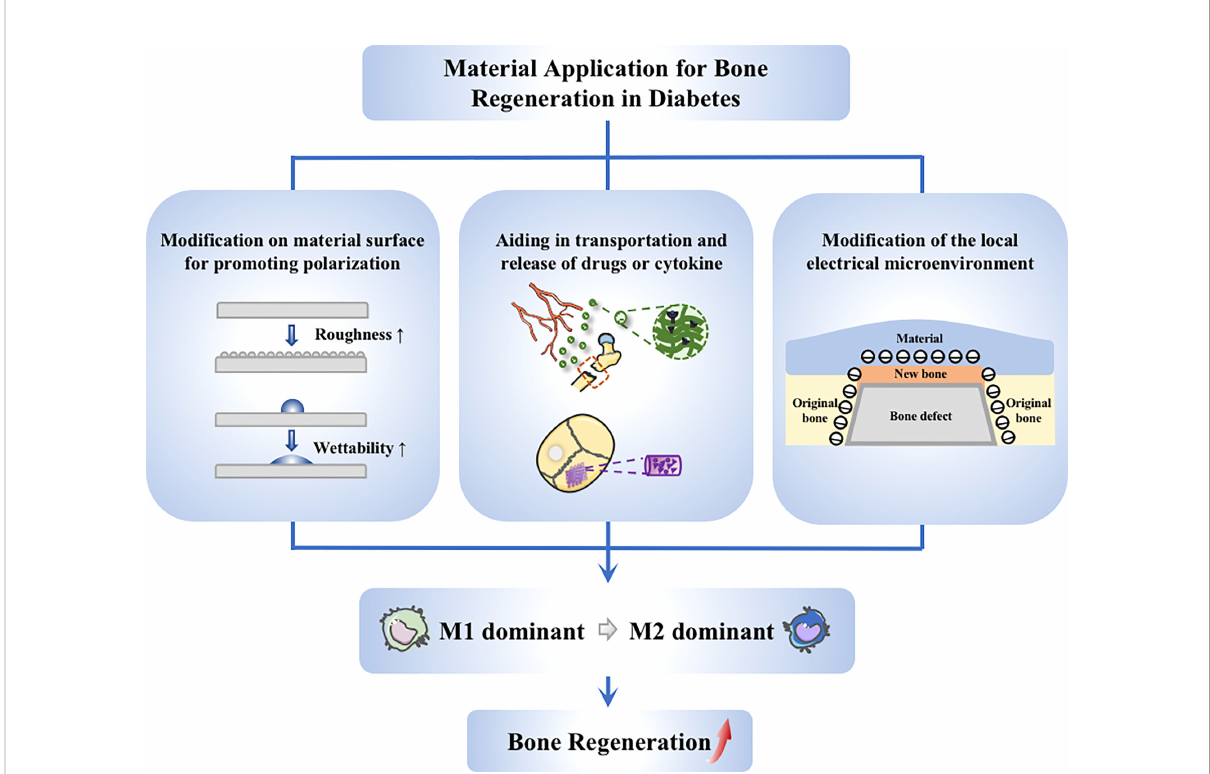
FIGURE 4 Application of materials targeting to macrophages. Strategies on material application to promote diabetic bone regeneration mainly include these aspects: (1) Guiding of macrophage switching by material modi fi cation, such as changing the surface roughness and wettability; (2) Stimulation of macrophages via drug delivery system, achieving better anchoring of drugs at the site of injury; (3) Modulation of macrophages through electrical microenvironment construction, creating a local pro-polarizing microenvironment to promote the transmission from M1 to M2